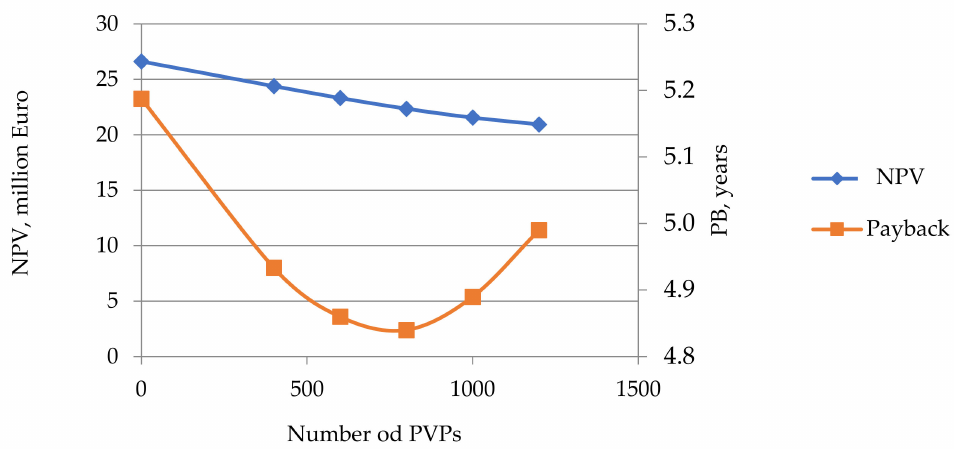
Figure 6. Change in the NPC and the PB for an HES, consisting of 2 WTs and PVPs, depending on the number of PVPs.